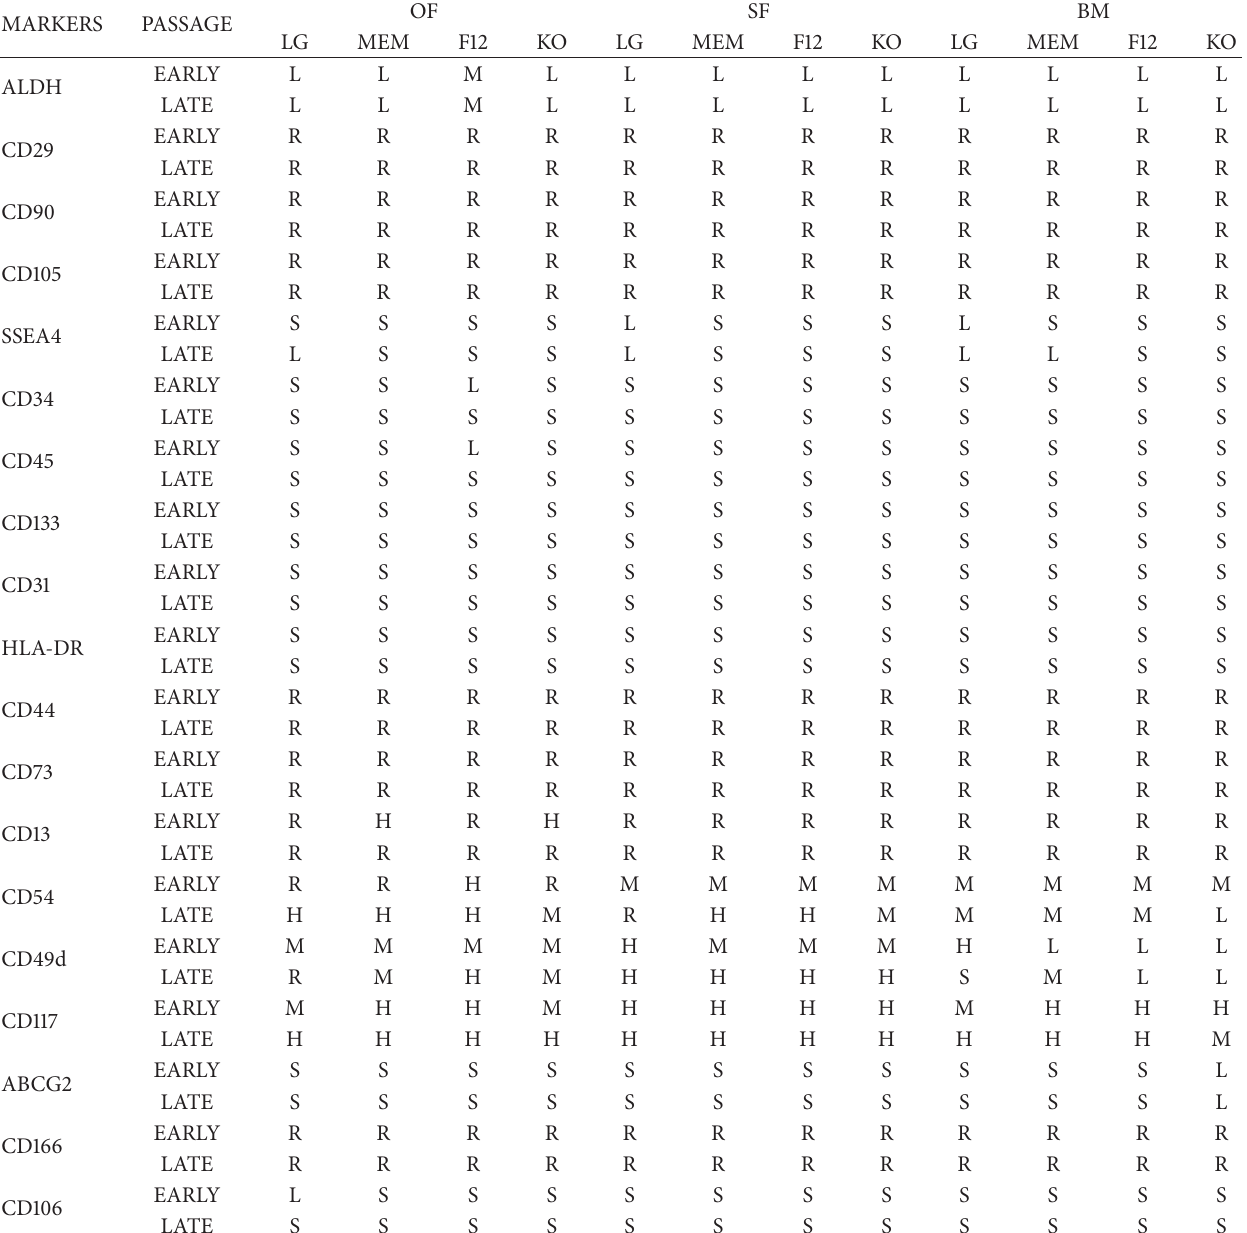
Table 1: Comparative analysis of ranges of marker expression